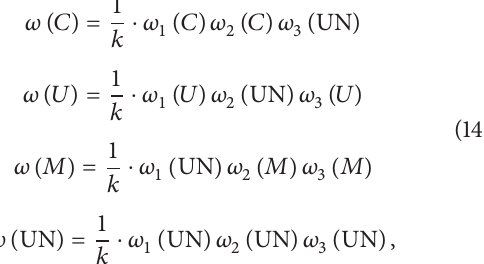
Figure 12: The first diagnostic example using the sequential diagno- sis